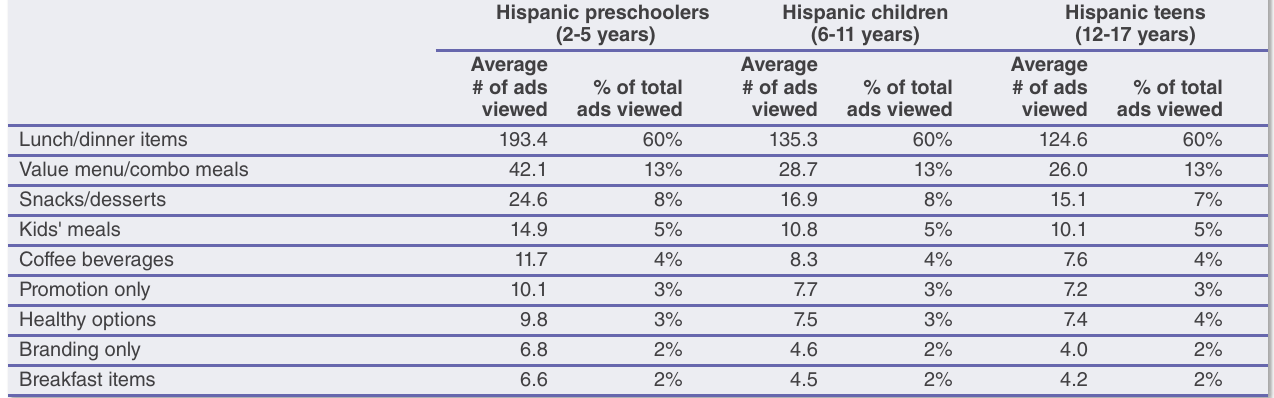
Table 39. Hispanic youth exposure to Spanish-language TV advertising by product type